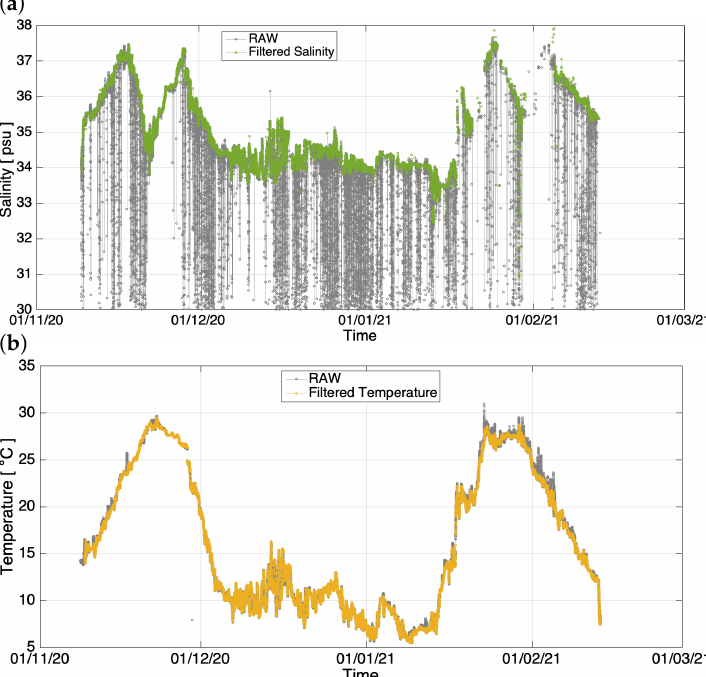
Figure 4. Temporal evolution of raw and filtered salinity data ( a ) and temperature ( b ) along the sailing race